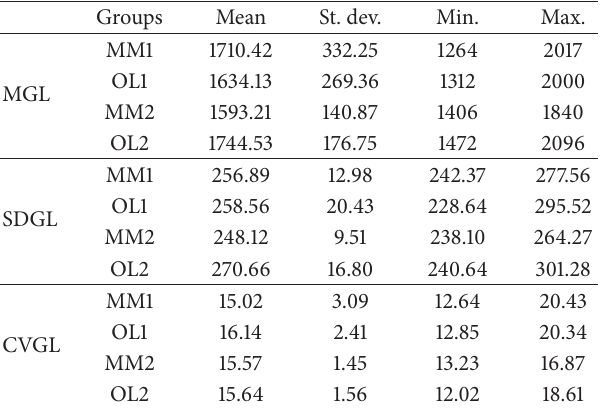
curve when comparing gray level parameters for flat